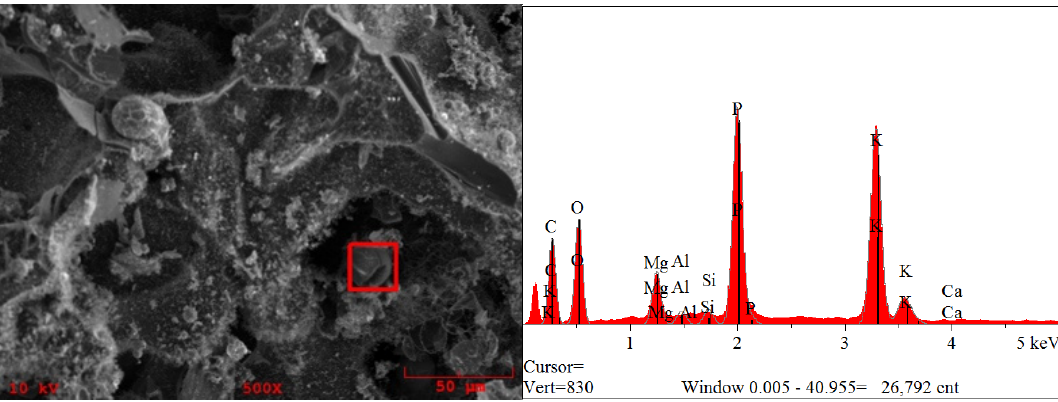
Figure 6. Surface area analysis from corn biochar (Elements from left to right K, C, O, Mg, Al, Si, P, K, Ca).